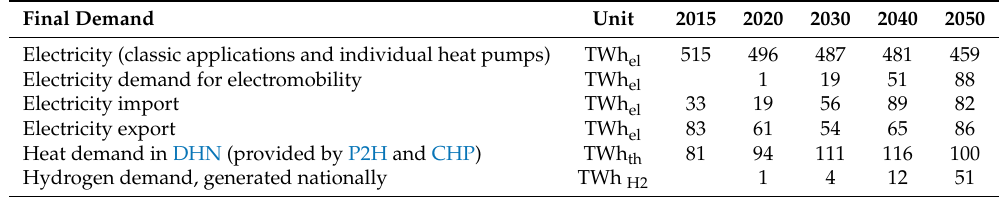
Table 1. Assumed development of electricity demand and adjacent sectors until 2050 according to